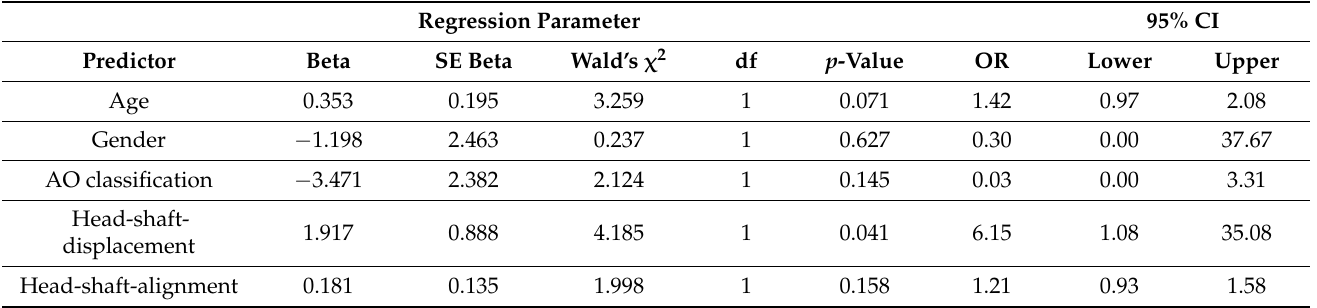
Table 6. Logistic regression for independent predictors of malreduction in patients with proximal humeral fractures. Regression with